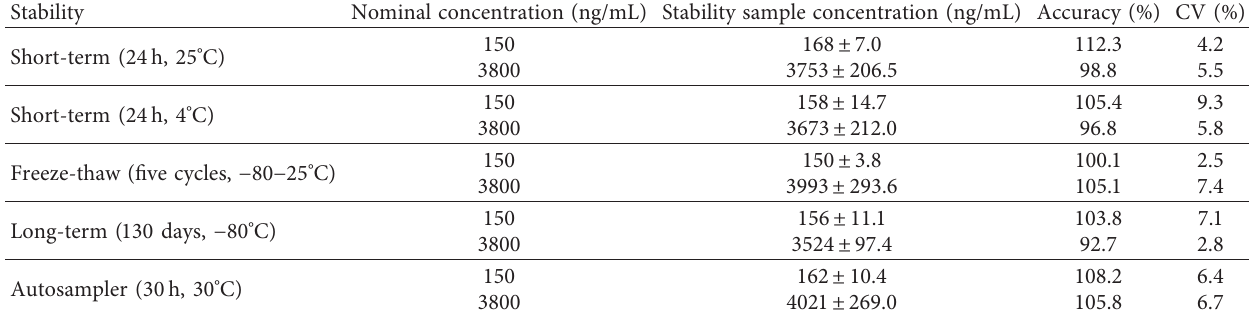
Table 3: Stability of TGC in human plasma under tested